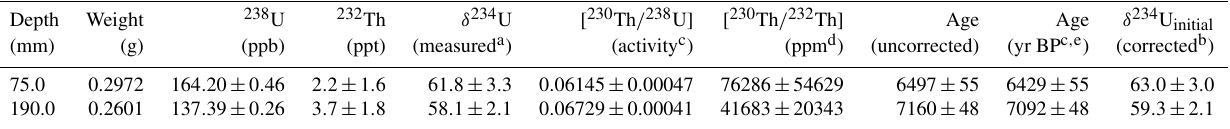
(cid:105) × (cid:104) 238 (cid:105) = (cid:104) 235 U 137 . 818 ( ± 0 . 65 ‰) (Hiess et al., 2012); δ 234 U U